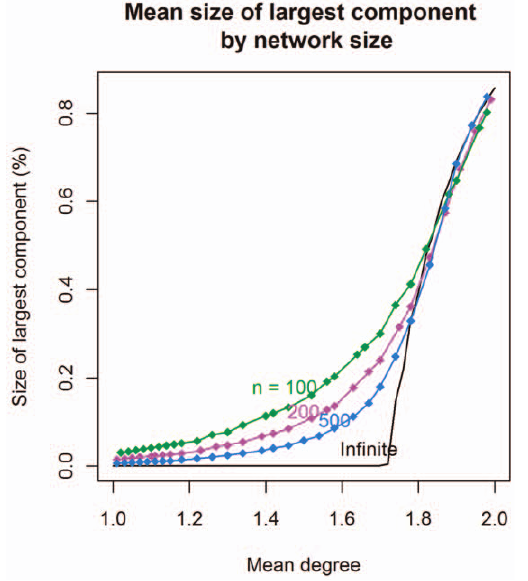
Figure 2. Mean size of the largest component as a function of network size and concurrency: We see here the average size of the largest component for networks of size 100, 200, and 500 nodes as the concurrency rises through the threshold level. The black line gives the analytic approximation for large networks. Notice that the curves for the small networks approach the analytic result as the network size increases. The small networks have the same threshold, but the behavior around the threshold is different. The flatter curve means that lower levels of concurrency produce higher levels of connectivity in small networks.